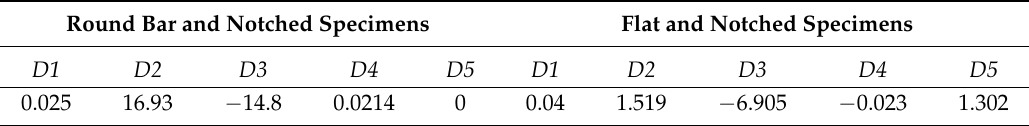
Table 4. Johnson-Cook fracture model parameters of AISI-1045 steel.